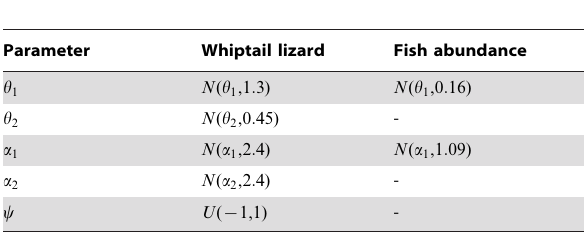
Table 2. Proposal distributions for RJMCMC within model moves of each